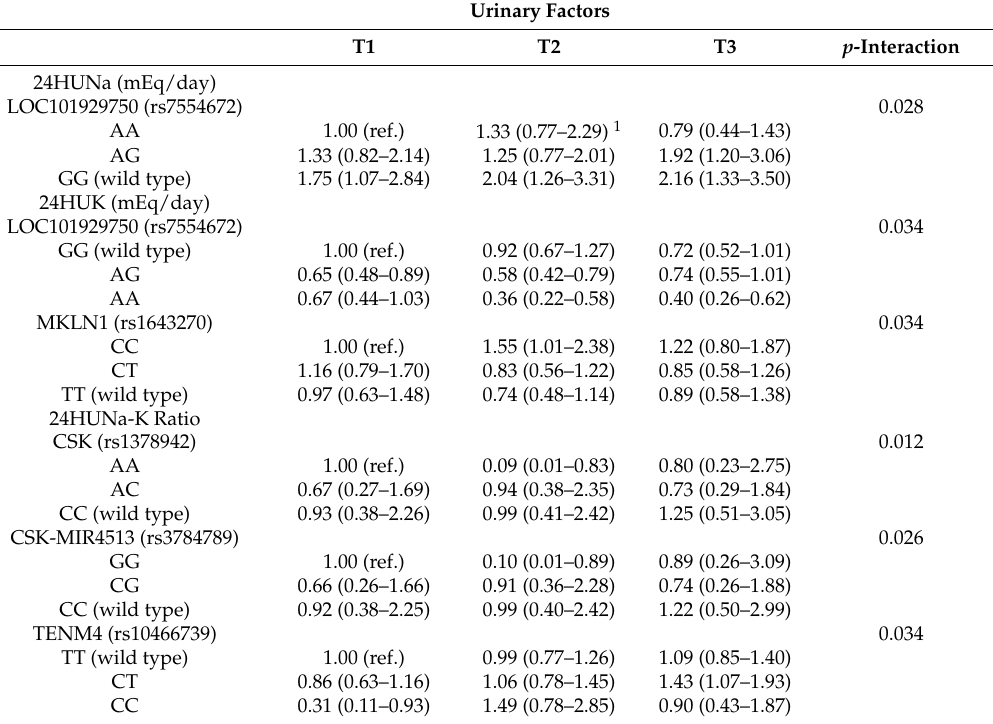
Table 6. Significant interactions between gene polymorphisms and 24 h estimated urinary factors obtained with Kawasaki formula in sample